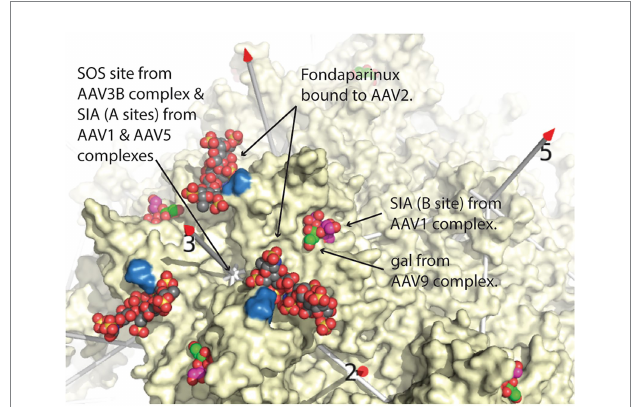
AAV2, from Stagg et al. (2022). Equivalent sites are shown surrounding one of the three-fold axes of symmetry of AAV. Arrows point to space- filling representations of fondaparinux, a heparin analog from the AAV2 cryo-EM complex (Xie et al., 2017), sialic acid (SIA, magenta carbons) from the AAV1 crystal structure (Huang et al., 2016), and galactose (gal; green carbons) from the cryo-EM AAV9 structure (Penzes et al., 2021), the latter two overlapping. Two arginines (585 & 588), important in AAV2 heparan-binding, are colored blue (Kern et al., 2003). Additional glycan attachment interactions for AAV1, AAV3B, and AAV5 have also been inferred through crystallography or mutational studies (Lerch and Chapman, 2012; Afione et al., 2015; Huang et al., 2016). Structures were overlaid by superimposing the AAV VP3 capsid proteins using the SSM sequence-structure alignment as implemented in Pymol (DeLano, 2002; Krissinel and Henrick, 2004; The PyMOL Molecular Graphics System, 2.0, 2015), and then expanding the icosahedral